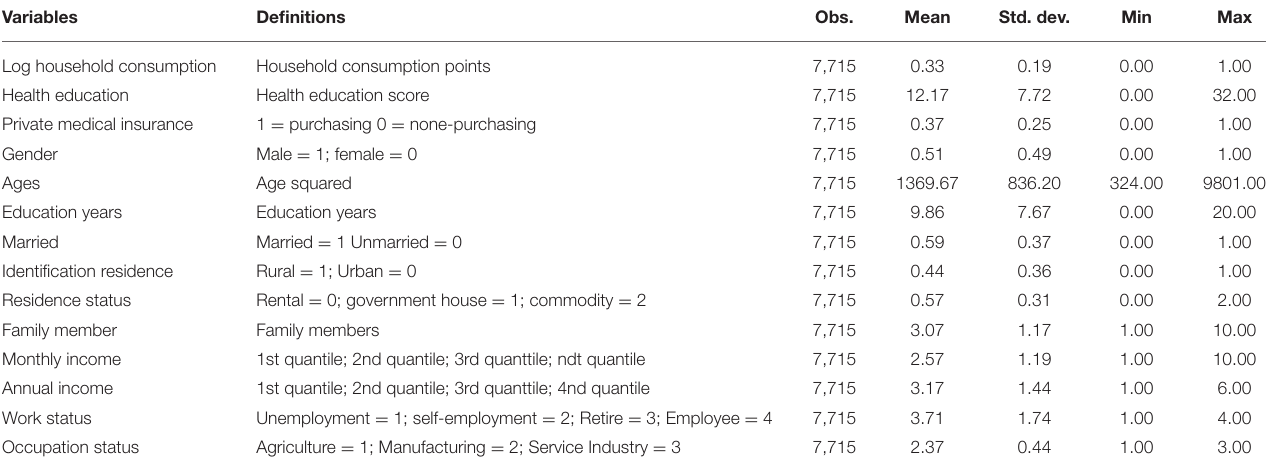
TABLE 1 | Socioeconomic statistic.